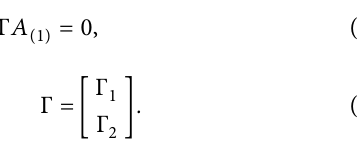
| / | U | with respect to c fs s � with l 0 0